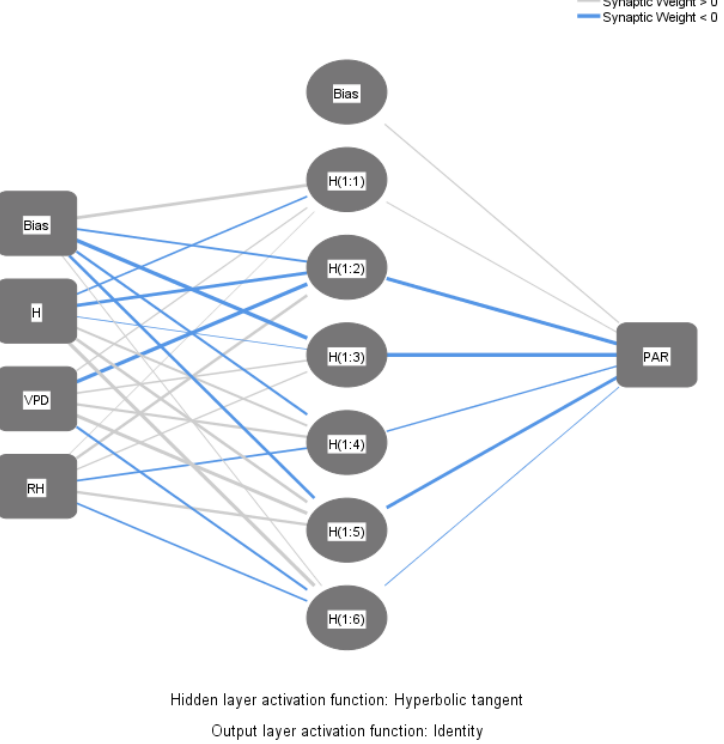
Figure 3. Schematic diagram of the best-performing model (model 11) using multi-layer perceptron (MLP).